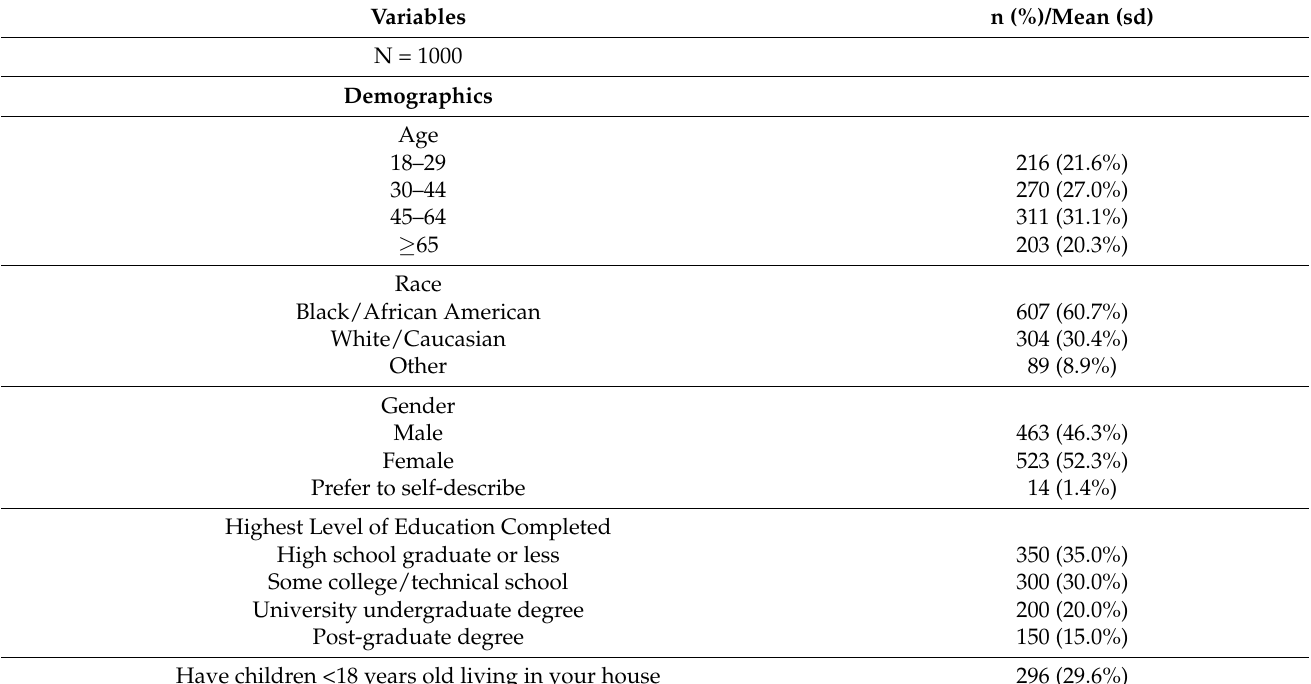
Table 1. Participant